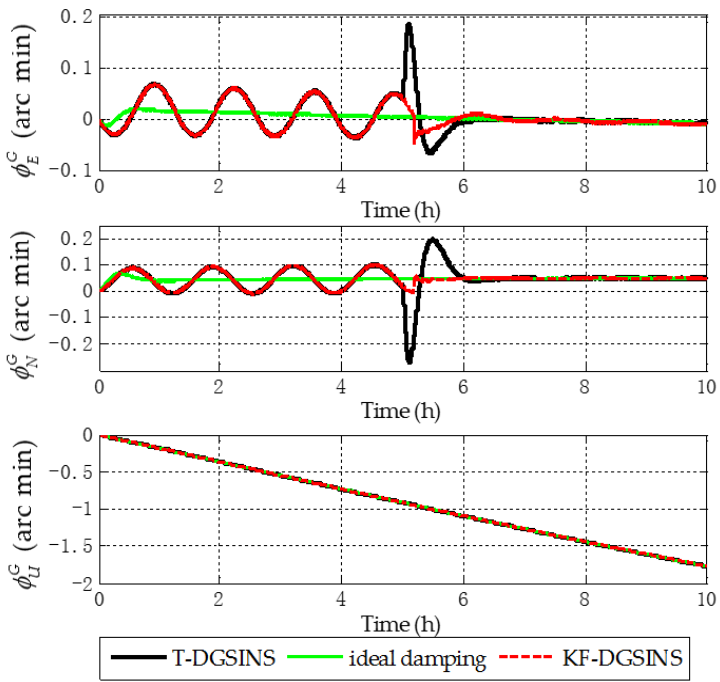
Figure 9. Grid attitude angle errors of the simulation results.